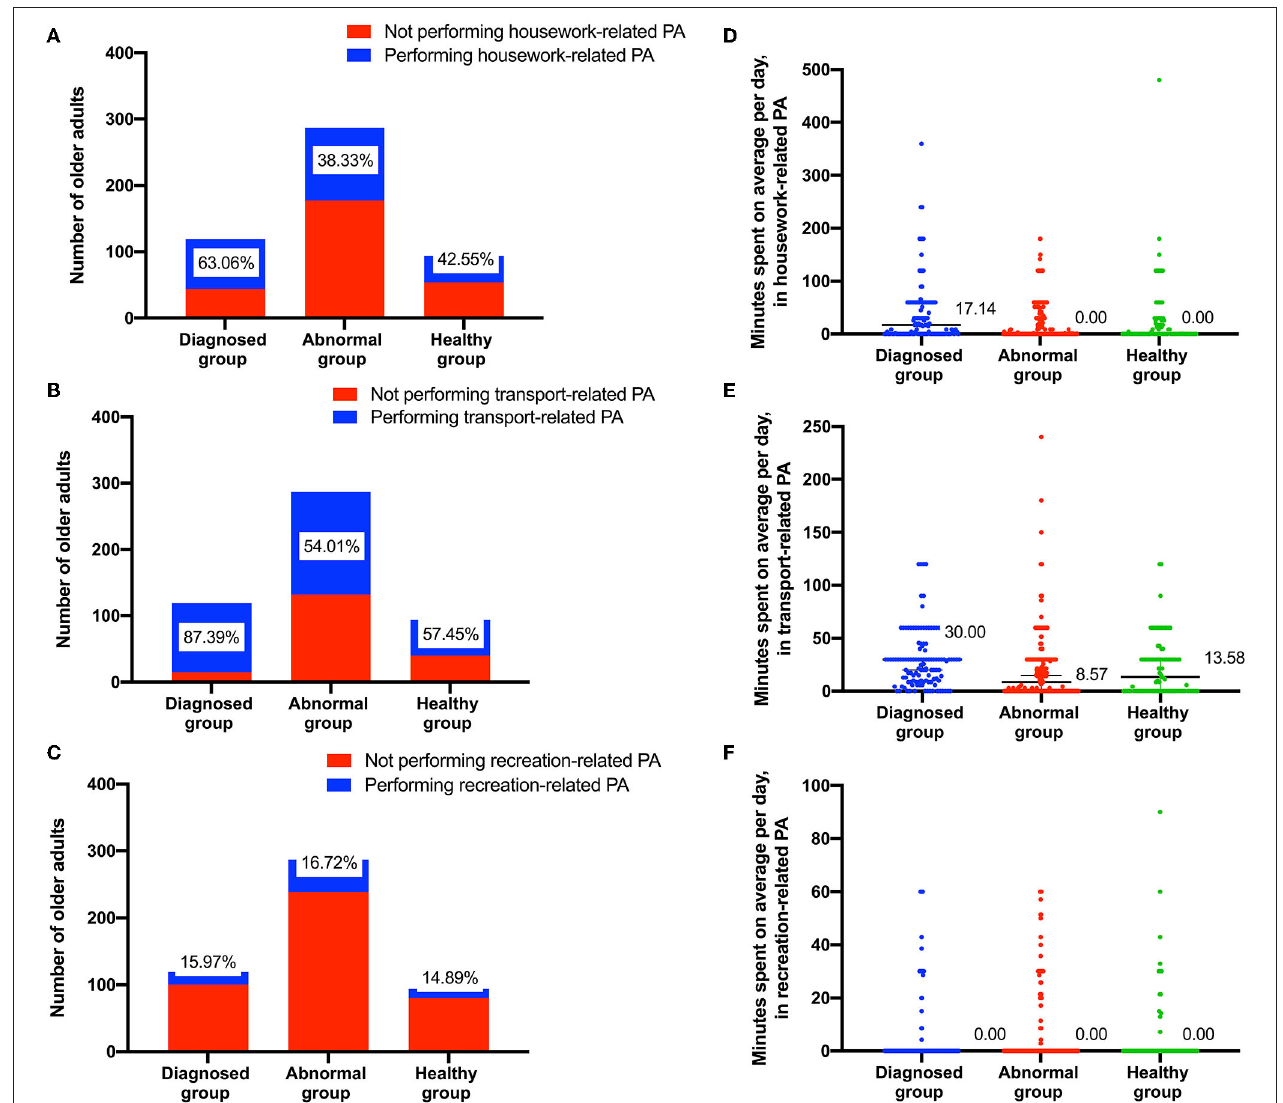
FIGURE 1 | Elderly individuals engaged in three types of PA in three health status groups. (A–C) count the number and proportion of older adults participating in the specific type of PA. (D–F) show the minutes each older adults spent on the specific type of